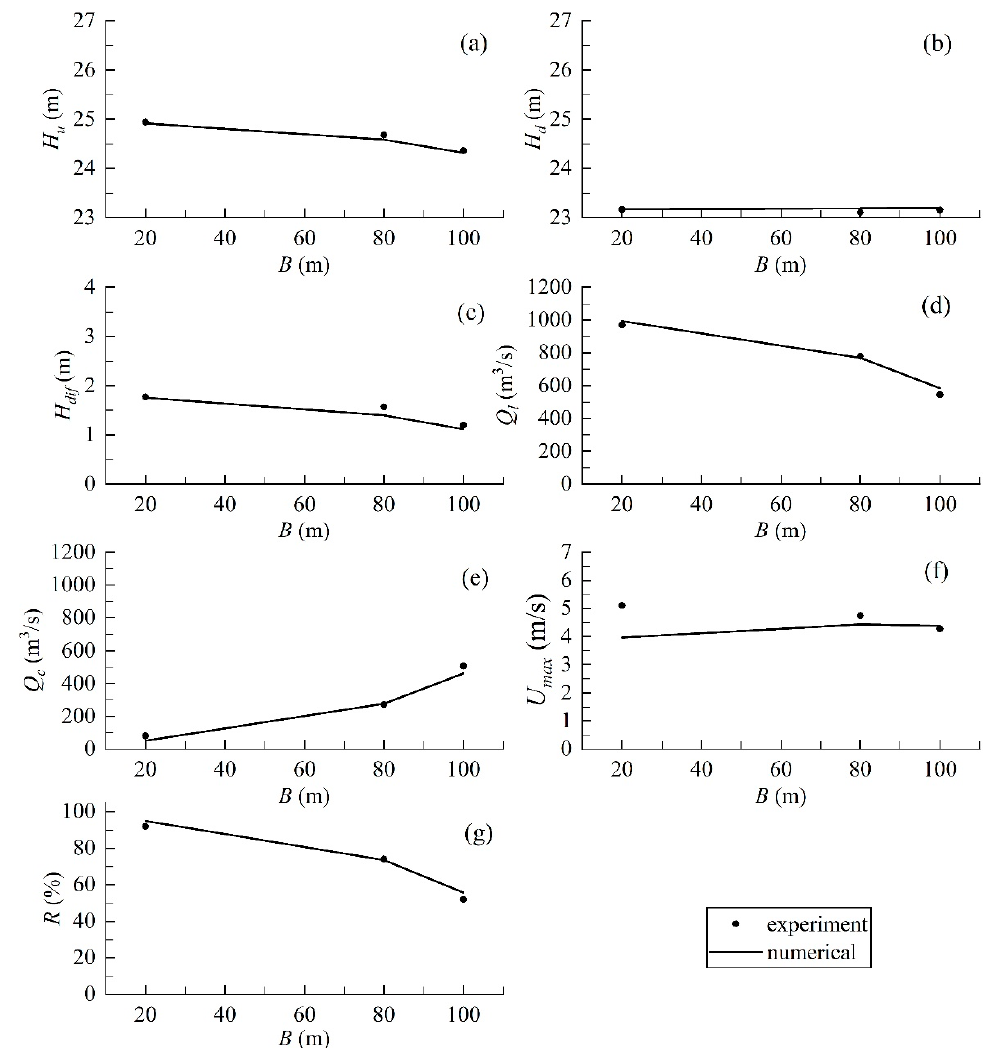
Figure 9. Comparison between numerical results and experimental data under working condition 3: ( a ) upstream water level; ( b ) downstream water level; ( c ) water level difference; ( d ) flow rate of low holes; ( e ) flow rate of closure gap; ( f ) maximum velocity; ( g ) split flow rate.